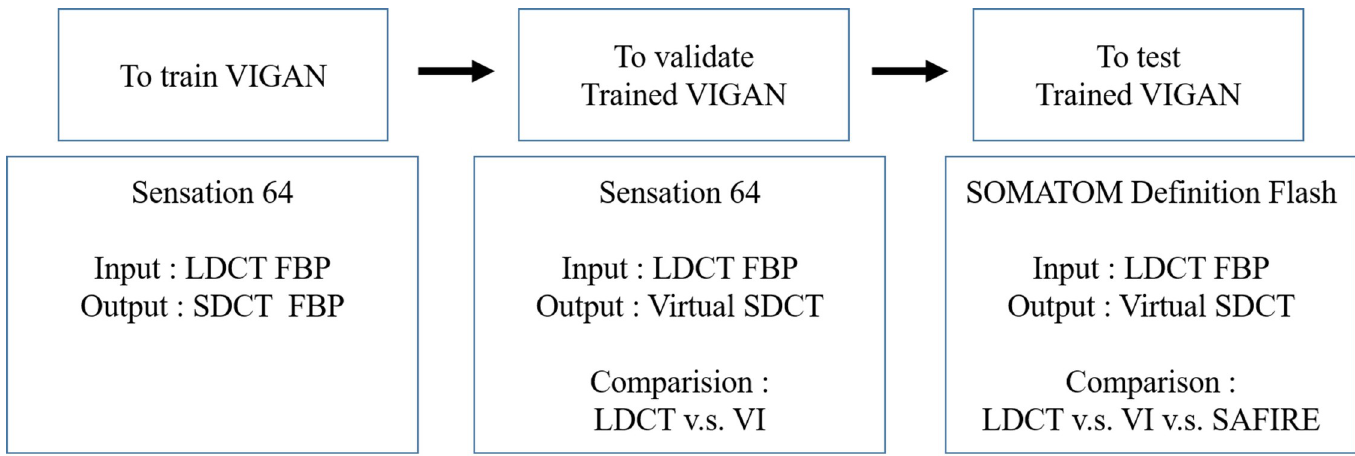
Fig 1. Flow diagram of study. � VIGAN = generative adversarial network for virtual standard dose CT image, LDCT = low dose computed tomography, SDCT = standard dose CT, VI = virtual image, SAFIRE = sinogram affirmed iterative reconstruction.